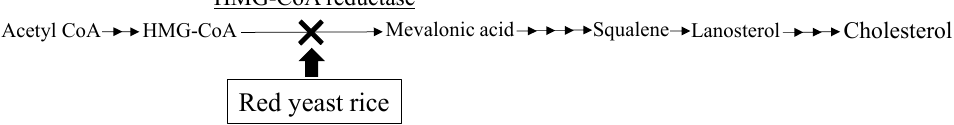
Figure 12. Biosynthetic pathway of cholesterol synthesis and the action of red yeast rice in it. Lovastatin and its analogs (including their derivatives) have been used as medicines since 1987 by Japanese and foreign pharmaceutical companies. Statins inhibit HMG-CoA reductase, lower hepatic cholesterol biosynthesis and elevate the expression of hepatic LDL-receptors to maintain cholesterol homeostasis, which in turn enhances uptake of LDL-cholesterol into the liver and decreases blood cholesterol levels [31–33]. LDL-choles- terol is known as bad cholesterol because it is involved in atheroma formation and causes atherosclerosis. Since statins have excellent LDL-cholesterol-lowering effects, they are used as first-line drugs for patients with hypercholesterolemia, and several world-wide large-scale clinical trials have been conducted on statins. These trials have demonstrated